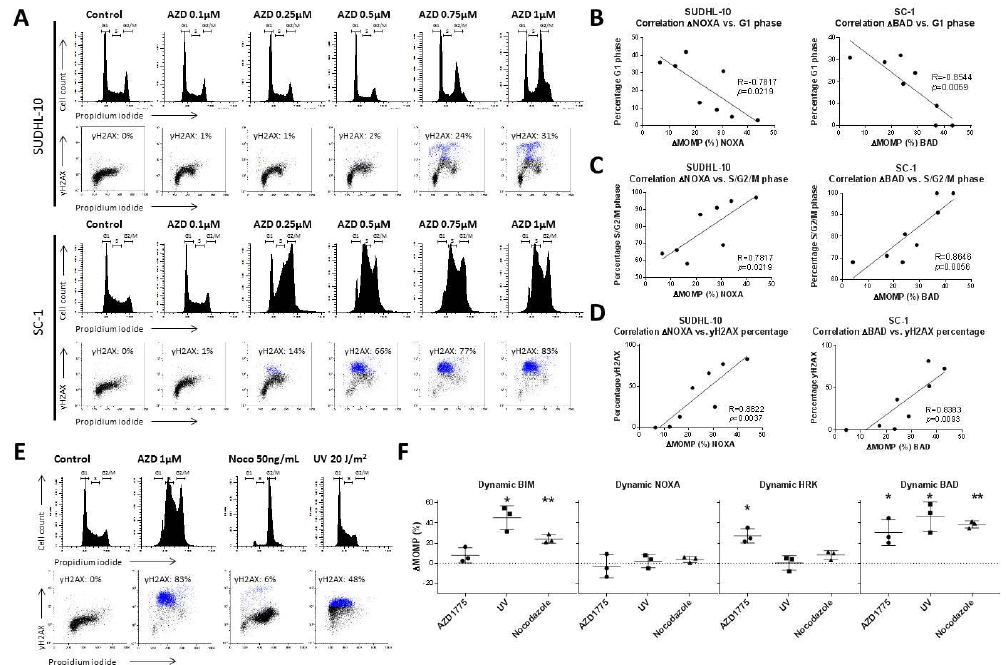
Figure 2. Cellular e ff ect of AZD1775 treatment in DLBCL. ( A ) Representative examples of flow cytometry cell cycle and γ H2AX analysis of AZD1775 in SUDHL-10 and SC-1 treated for 18 h. ( B ) Correlation of the mitochondrial response ( ∆ MOMP%) for 10 µ M NOXA in SUDHL-10 or 0.1 µ M BAD in SC-1 versus the percentage of G1 phase cells treated with AZD1775. ( C ) Correlation of the mitochondrial response ( ∆ MOMP%) for 10 µ M NOXA in SUDHL-10 or 0.1 µ M BAD in SC-1 versus the percentage of S / G2 / M phase cells treated with AZD1775. ( D ) Correlation of the mitochondrial response ( ∆ MOMP%) of 10 µ M NOXA in SUDHL-10 or 0.1 µ M BAD in SC-1 versus the percentage of γ H2AX cells treated with AZD1775. Cells were treated with 0, 0.1, 0.2, 0.3, 0.4, 0.5, 0.75, or 1.0 µ M AZD1775 for 18 h. ( E ) Representative examples of cell cycle flow cytometry and γ H2AX analysis in SC-1 treated with 1 µ M AZD1775, 50 ng / mL nocodazole, and 20 J / m 2 UV radiation. ( F ) Dynamic BH3 profile for 0.3 µ M BIM, 10 µ M NOXA, 10 µ M HRK, and 0.1 µ M BAD of SC-1 cells treated with AZD1775, nocodazole, and (ultra violet) UV radiation. Data were plotted as the mean ± SD ( n = 3). Statistical analysis was performed using a one-sample t -test as compared to untreated control cells (* p ≤